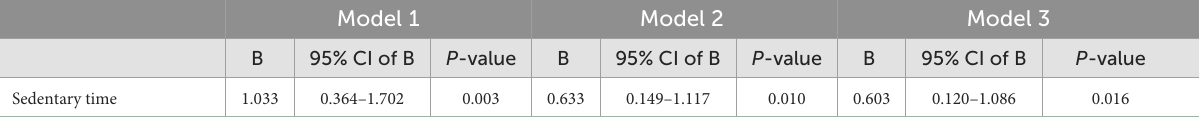
TABLE 3 Multiple linear regression analysis for leptin levels in relation to sedentray time after adjustment for potential